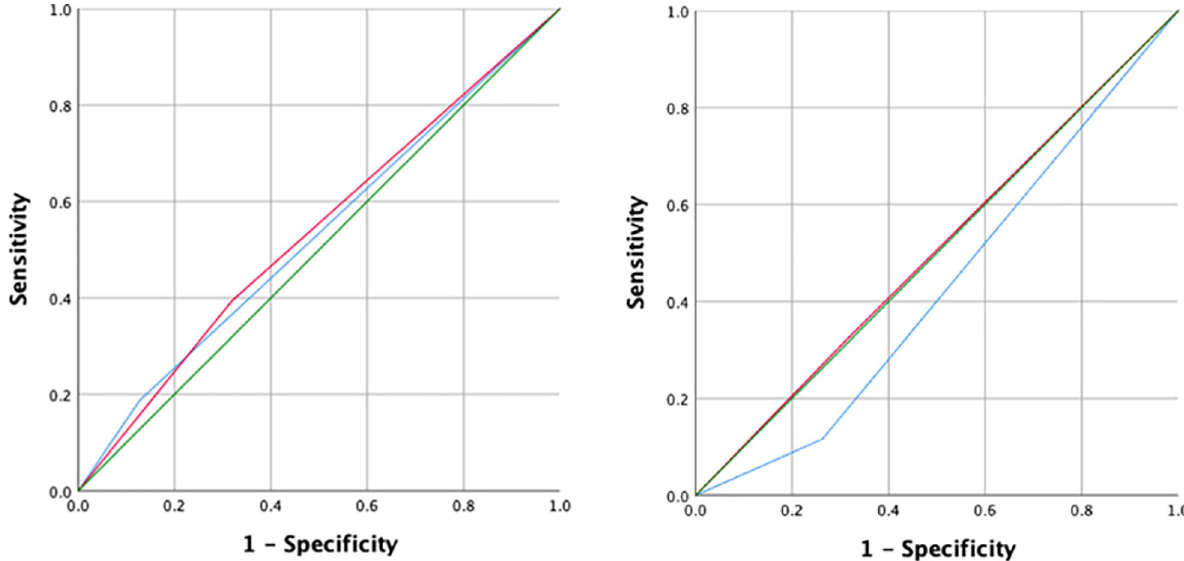
Fig 4. Receiver operating characteristic (ROC) curves for reported history of dengue illness as personal history (blue) and family history (red) against Hemagglutination inhibition (HAI) results. Graphs show (Left) children aged 9–17 years old (Right) adults aged 18–45 years old.